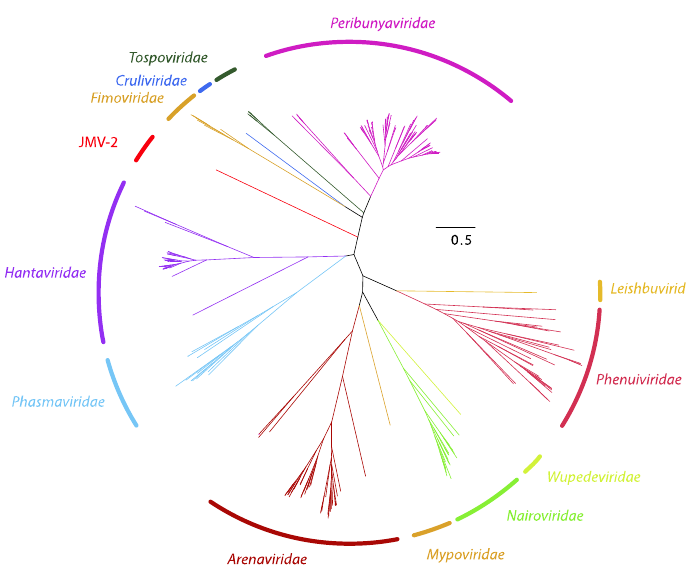
Figure 2. Bayesian inference of the L segment of Bunyavirales. A maximum clade credibility tree of the complete amino acid sequence of the protein encoded by the L segment of viruses belonging to Bunyavirales .